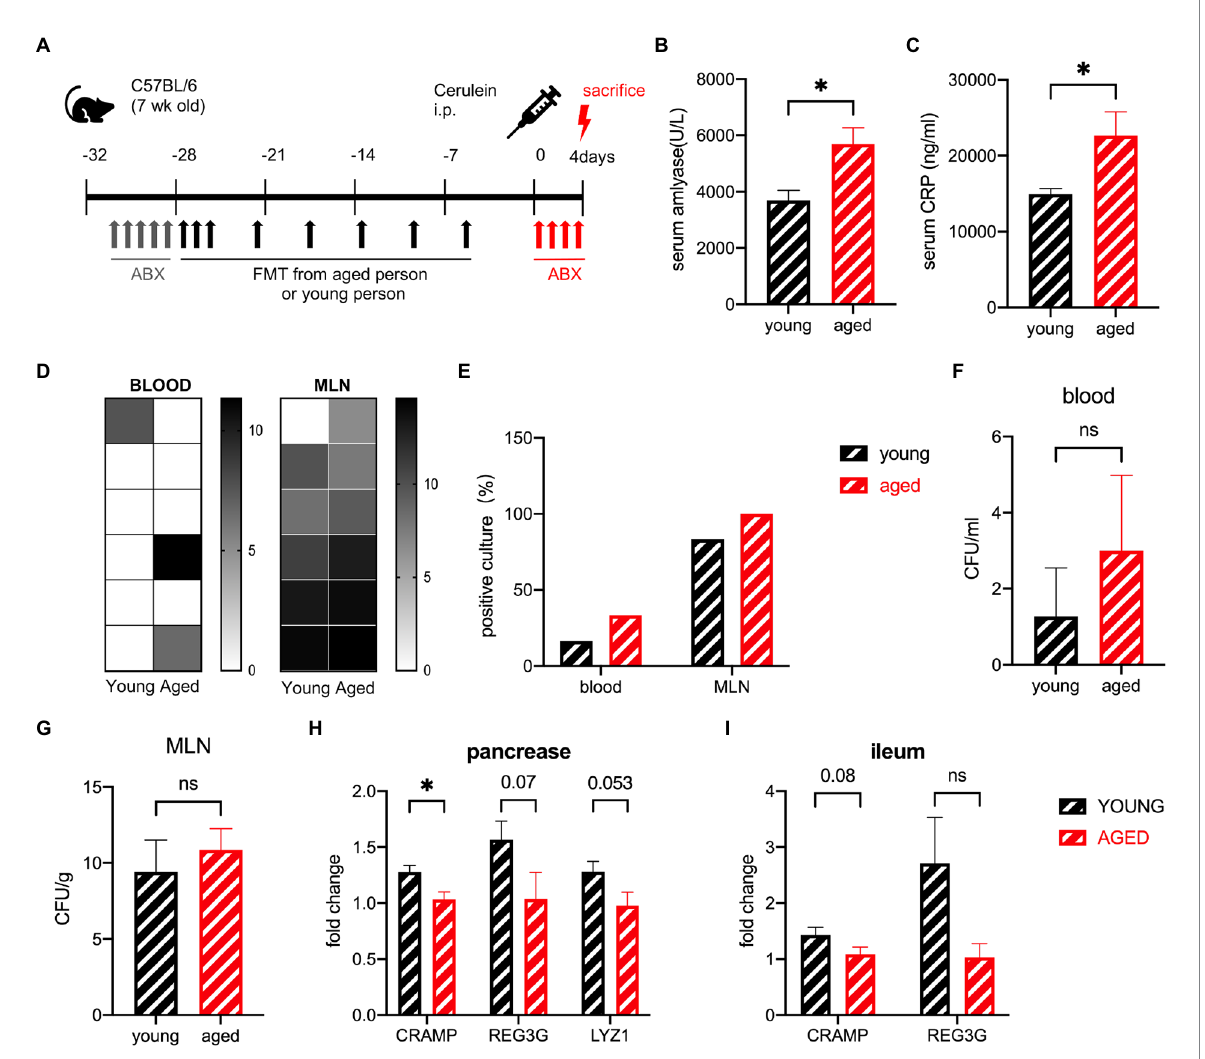
FIGURE 8 (A) Experimental design for gut depletion after SAP. (B) Serum amylase levels are significantly increased in the old group compared to the young group. (C) Serum CRP levels are significantly increased in the old group compared to the young group. (D) Heatmap of the CFU (log2) of blood and MLN. (E) Frequency of culture positivity in blood and MLN. CFU in the blood (F) and MLN (G) . Expression of AMP genes in the pancreas (H) and ileum (I) of the young group versus the old group (n = 6 per group). * p < 0.05, ** p < 0.01, *** p < 0.001, **** p < 0.0001, ns, no significant